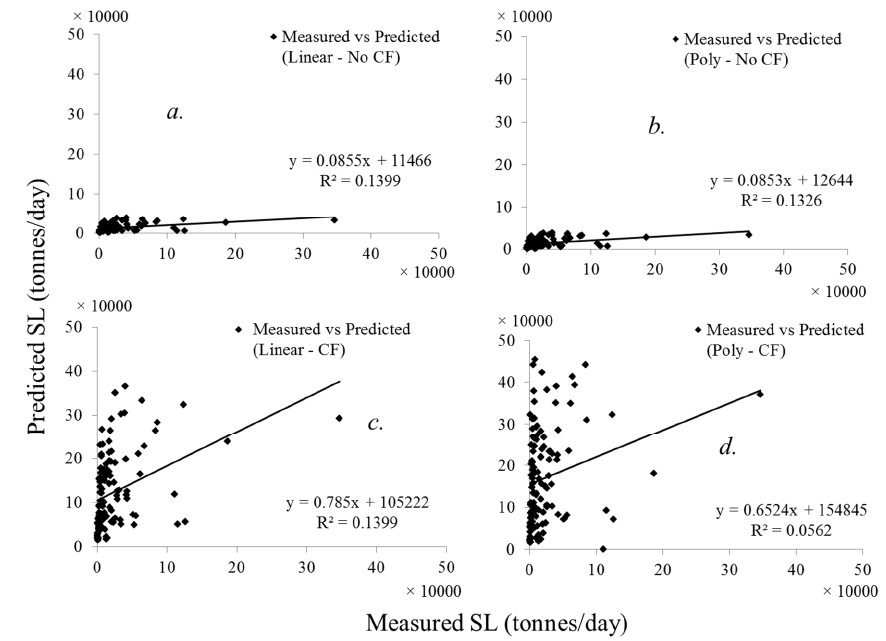
Figure 4. Scatter plots showing comparison between sand loads calculated from sand concentrations measured, processed and calibrated by USGS (Measured SL) and those predicted from single sand-rating curve (either linear or polynomial) (Predicted SL) at Tarbert Landing from 1986 to 1990. Specific terminologies pertaining to parts ( a ), ( b ), ( c ) and ( d ) of this figure i.e. , Linear, Poly, CF, and No CF are same as explained in Figure 2.